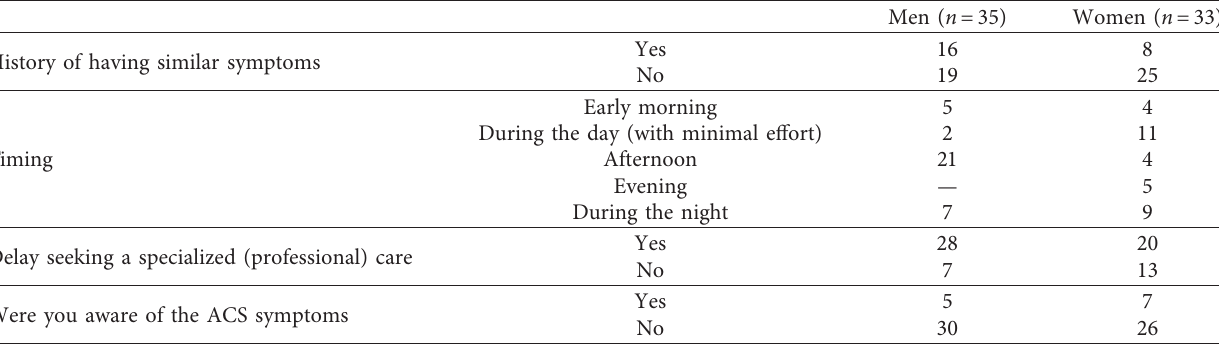
Table 3: Timing and history of the ACS